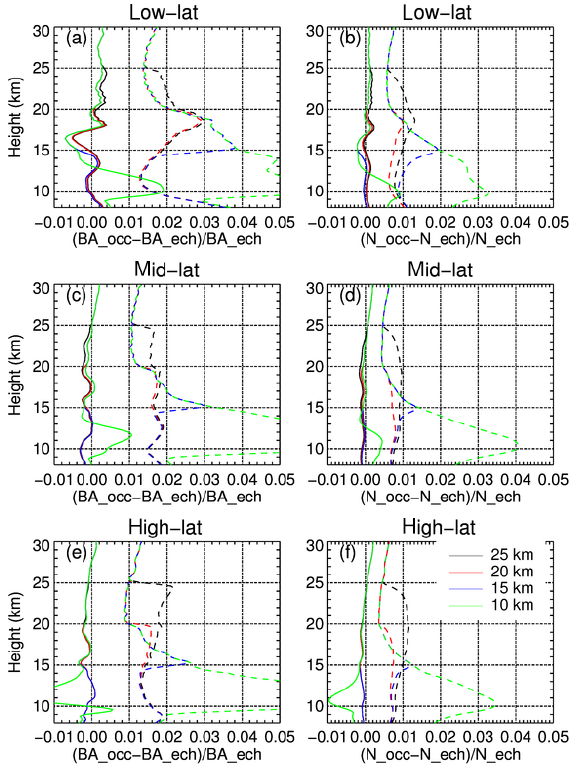
Figure 5. Mean differences (solid) and standard deviations (dashed) of retrieved COSMIC L2P bending angles (left) and refractivities (right) for different extrapolation (transition) heights (colors indi- cated in panel f ), relative to the colocated ECMWF forecast data over low (a, b) , mid- (c, d) , and high (e, f) latitudes.